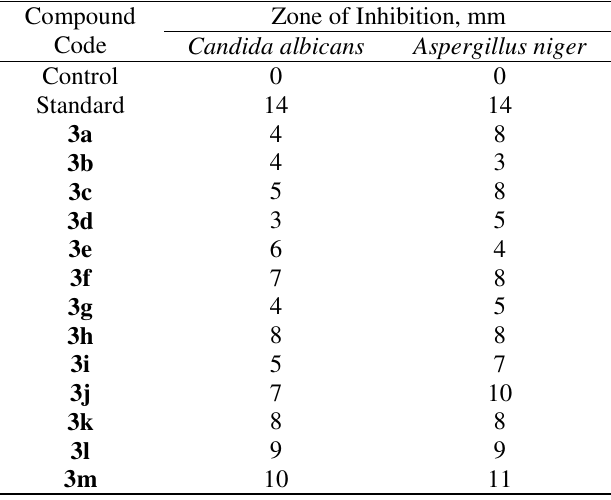
10 11 Standard: Griseofulvin, Control: Dimethyl